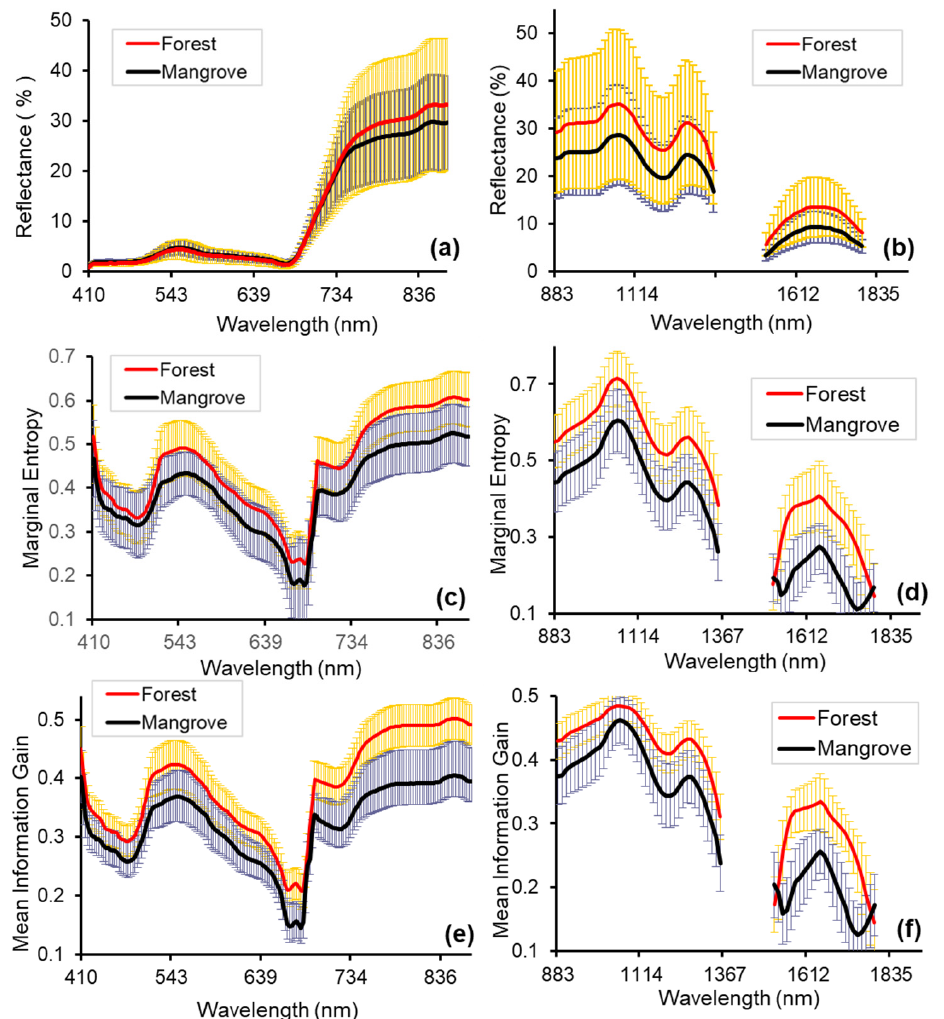
Figure 6. Comparison of mangrove and forest reflectance (%) (mean and standard deviation of 250 pixels), Marginal Entropy (ME), and Mean Information Gain (MIG): ( a ) spectral reflectance in the VNIR (2.5 m); ( b ) spectral reflectance in the SWIR (2.5 m); ( c ) ME -VNIR (250 m); ( d ) ME -SWIR (62.5 m); ( e ) MIG -VNIR (250 m); ( f ) MIG-SWIR (62.5 m). Scales with the best separability between forest and mangrove for the SCM are shown (see Section 3.3). The MIG and ME values of forest were larger than that of mangrove from the VNIR to the SWIR region of the electromagnetic spectrum except at 1516 nm and 1792 nm. In the VNIR portion of the spectrum, the difference between forest and mangrove ranged between 0.03–0.1 for MIG and 0.02–0.08 for ME. In the SWIR portion of the electromagnetic spectrum, the difference between forest and mangrove ranged between 0.01 to 0.13 for MIG and 0.02–0.18 for ME. The greatest differences between both mean MIG and ME of forest and mangrove were recorded in the NIR (>765 nm) and between the wavelength ranges 1553 nm–1738 nm for SWIR (Figure 6).